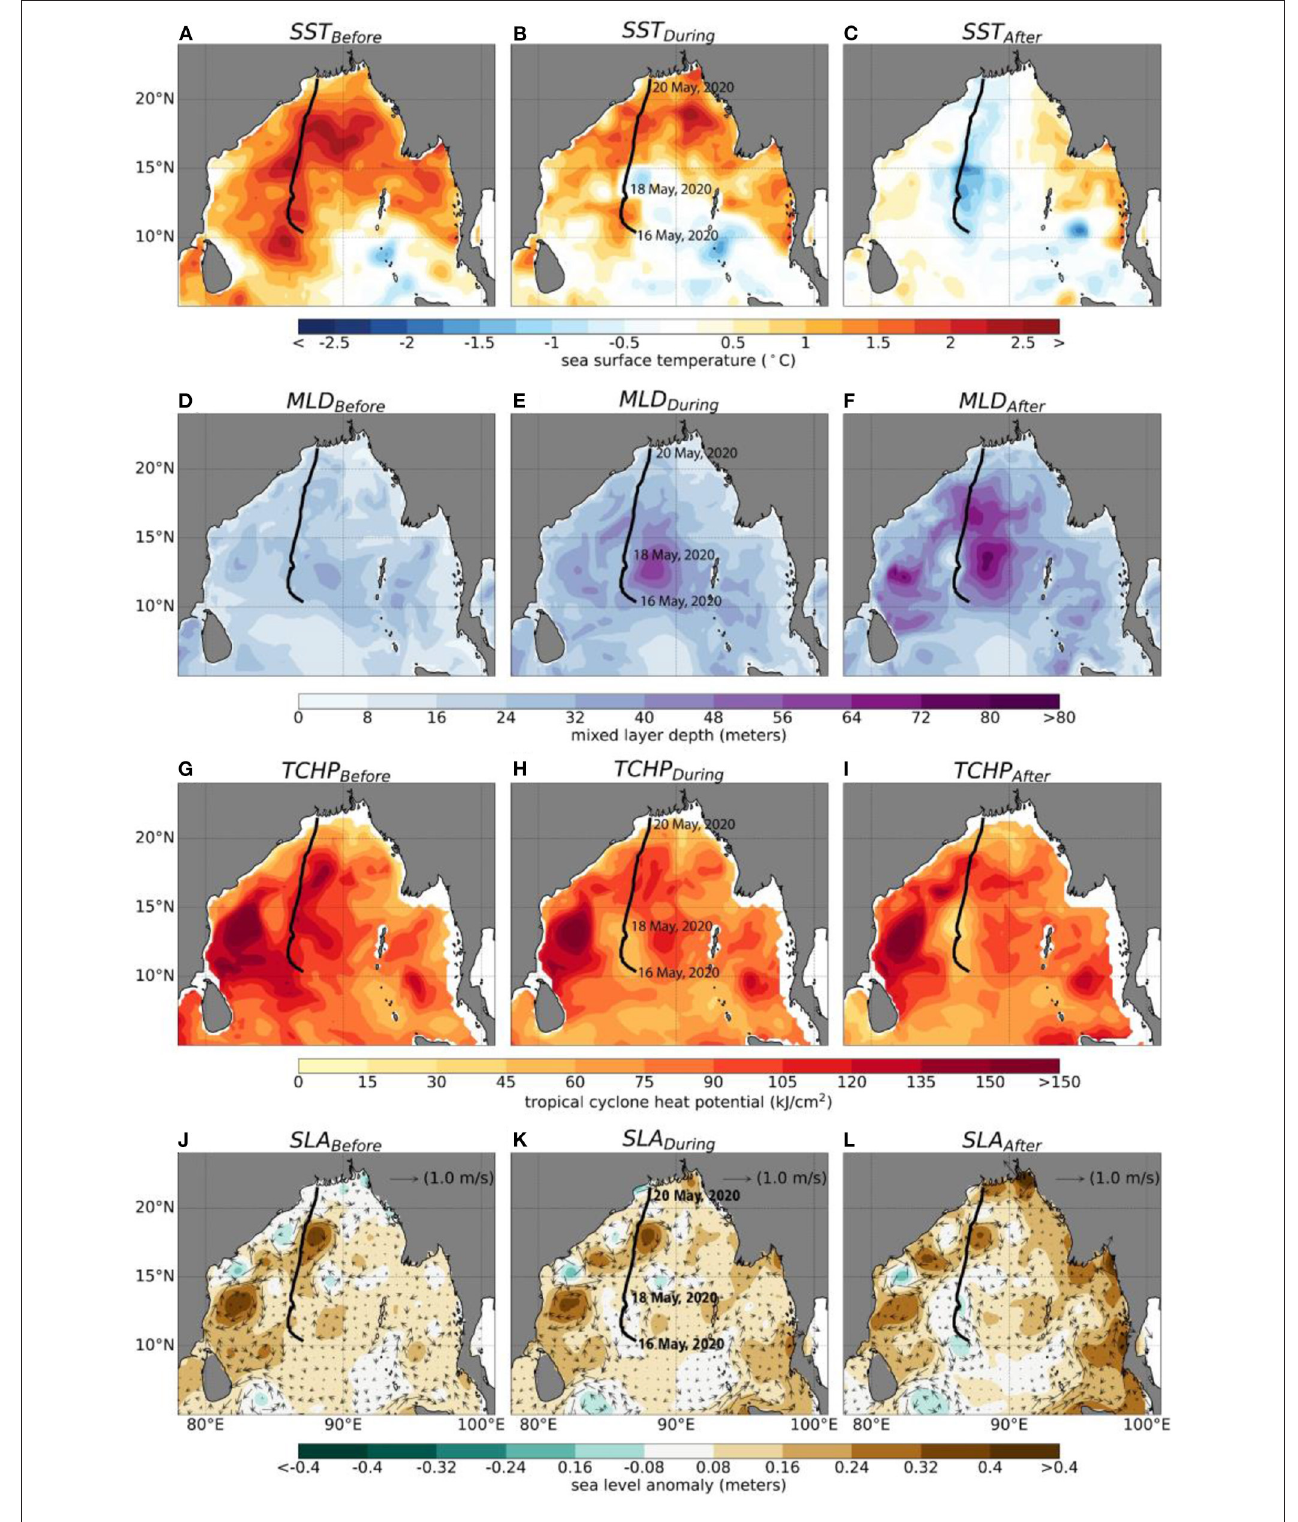
FIGURE 10 | Five days averaged basin-wide features of (A–C) S ea surface temperature anomaly ( ◦ C), (D–F) mixed layer depth (M), (G–I) tropical cyclone heat potential (kJ cm − 2 ), (J–L) sea-level anomaly (m) overlaid by the geostrophic current vectors (m s − 1 ) before cyclone (first column), during cyclone (second column), and after cyclone (third column). The black line represents the track of the tropical cyclone Amphan. Dates representing cyclogenesis (16-May-2020), intensification (18-May-2020) and landfall (20-May-2020).